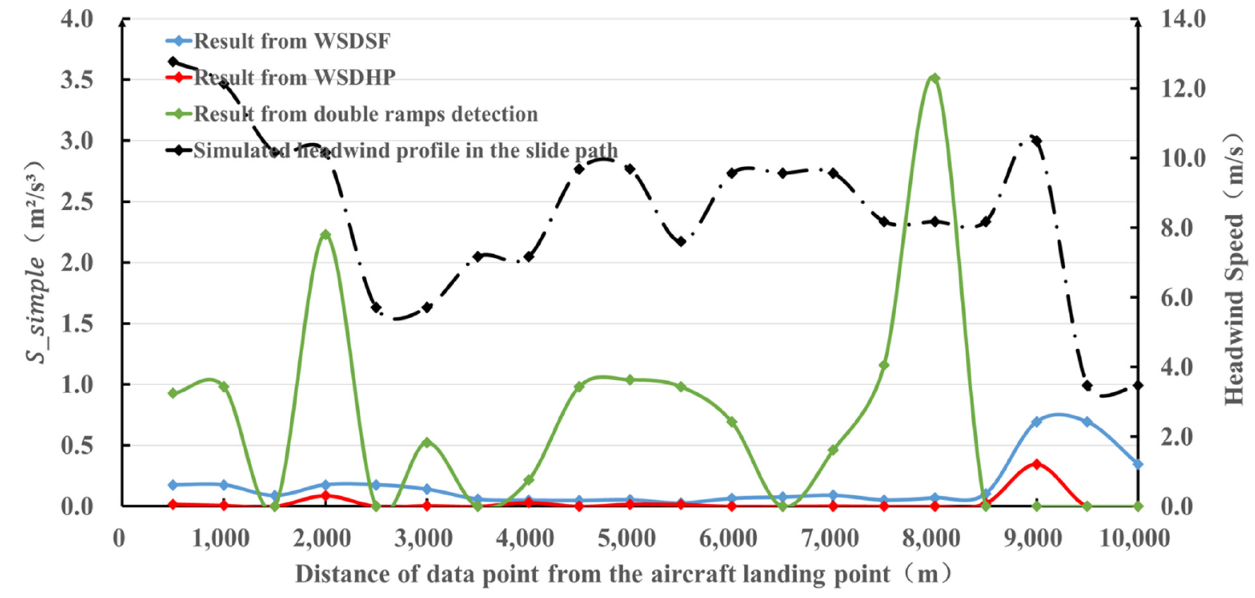
Figure 13. The results of wind shear detection under the background of the turbulent wind field.